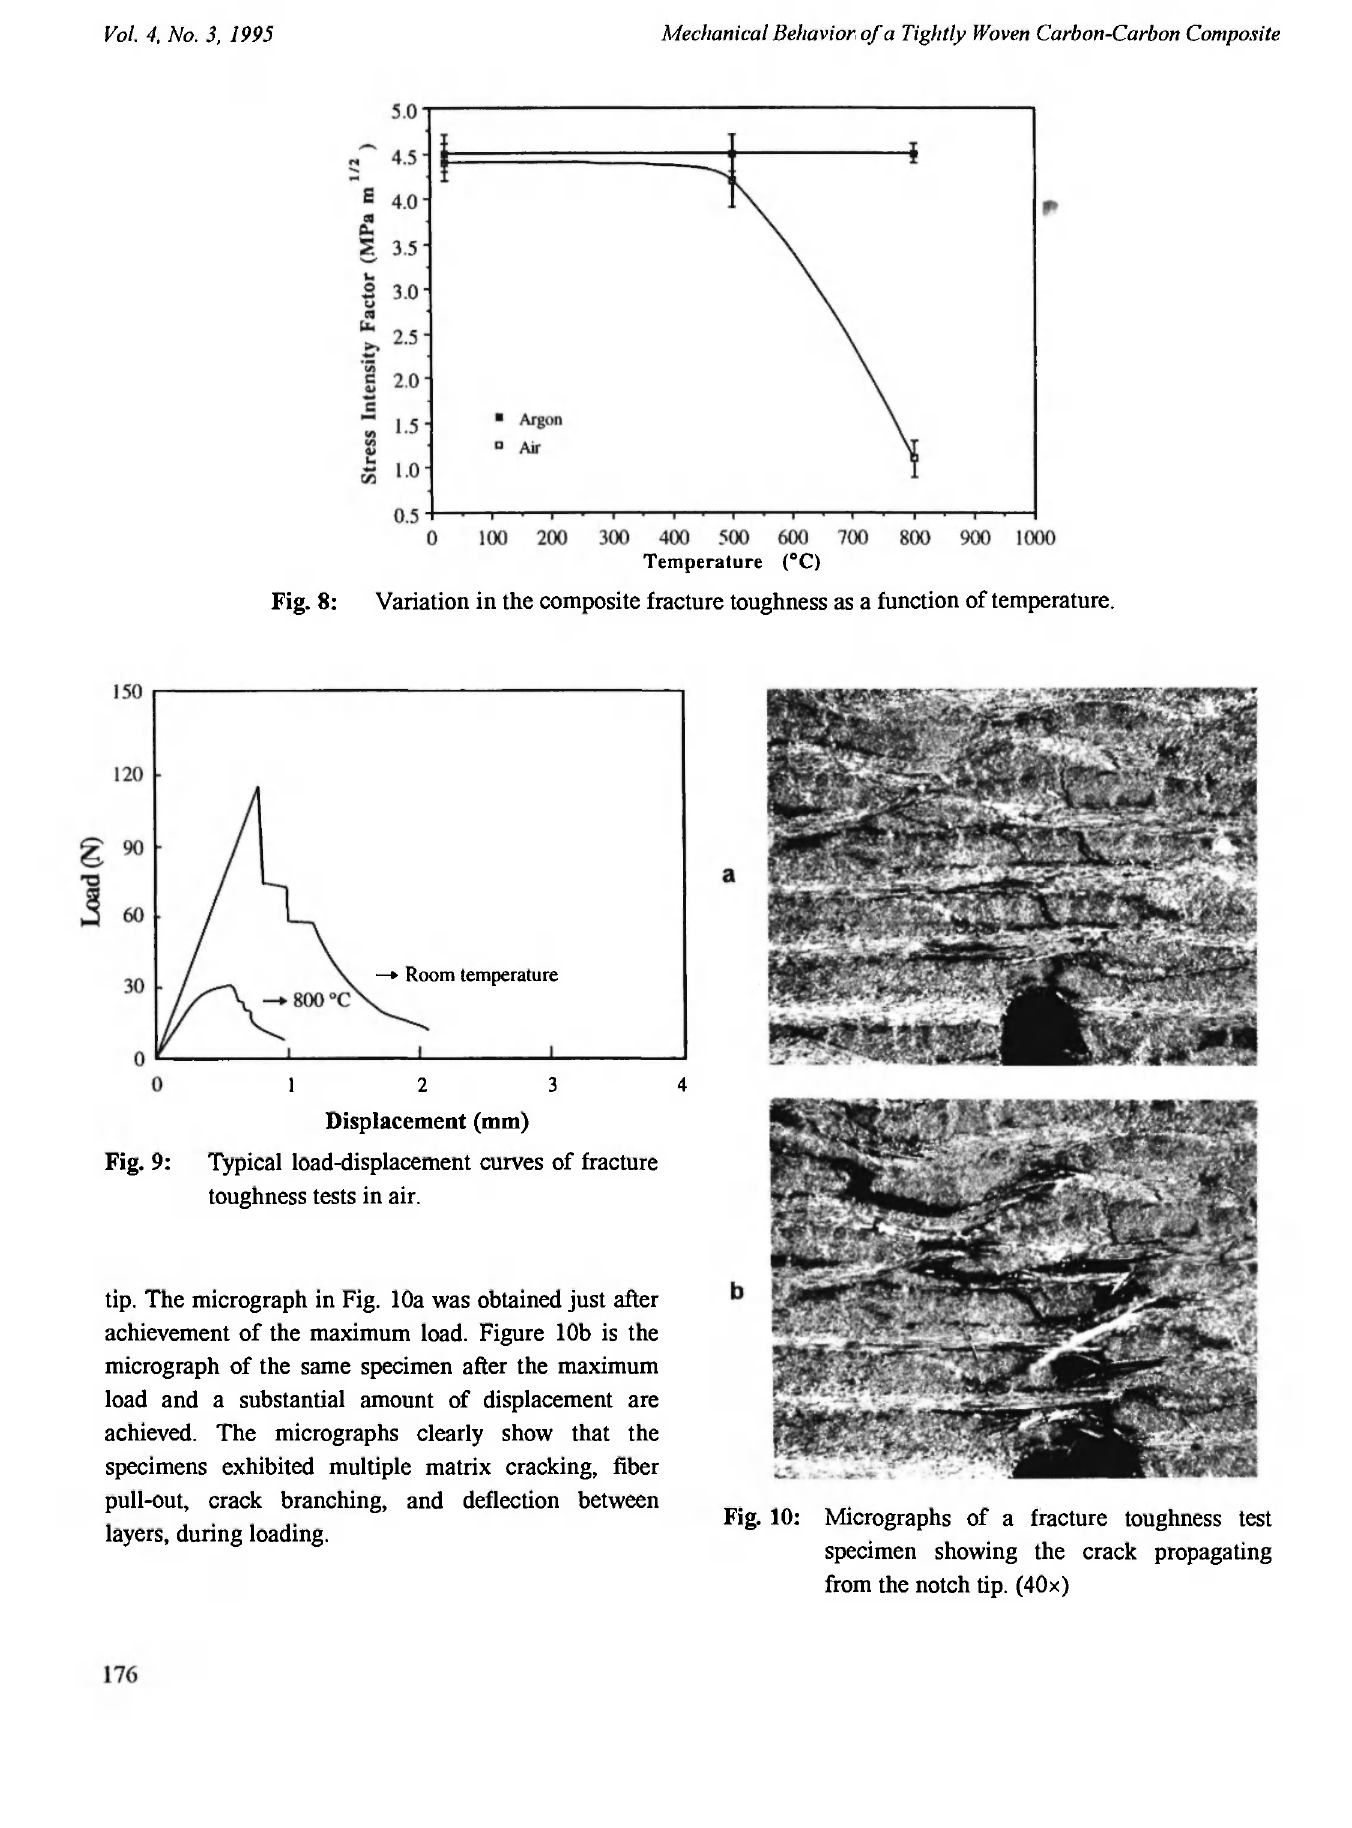
tip. The micrograph in Fig. 10a was obtained just after achievement of the maximum load. Figure 10b is the micrograph of the same specimen after the maximum load and a substantial amount of displacement are achieved. The micrographs clearly show that the specimens exhibited multiple matrix cracking, fiber pull-out, crack branching, and deflection between layers, during loading.